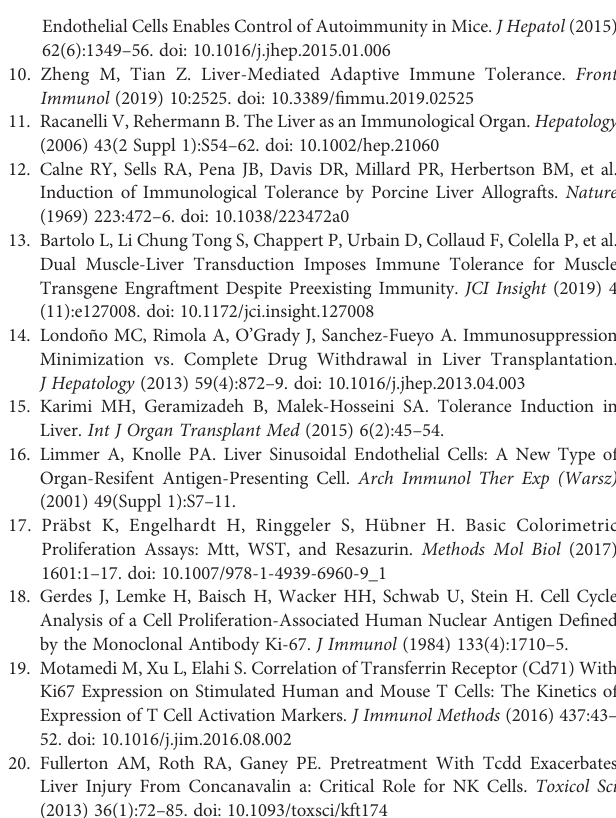
( Figure 4E ). Future research will focus on developing